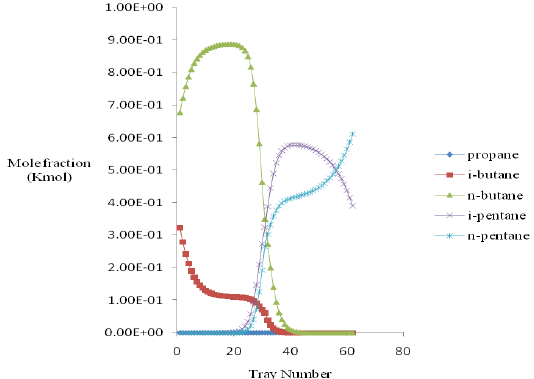
Figure 3. Molar Composition o f Depropanizer of the Base Case